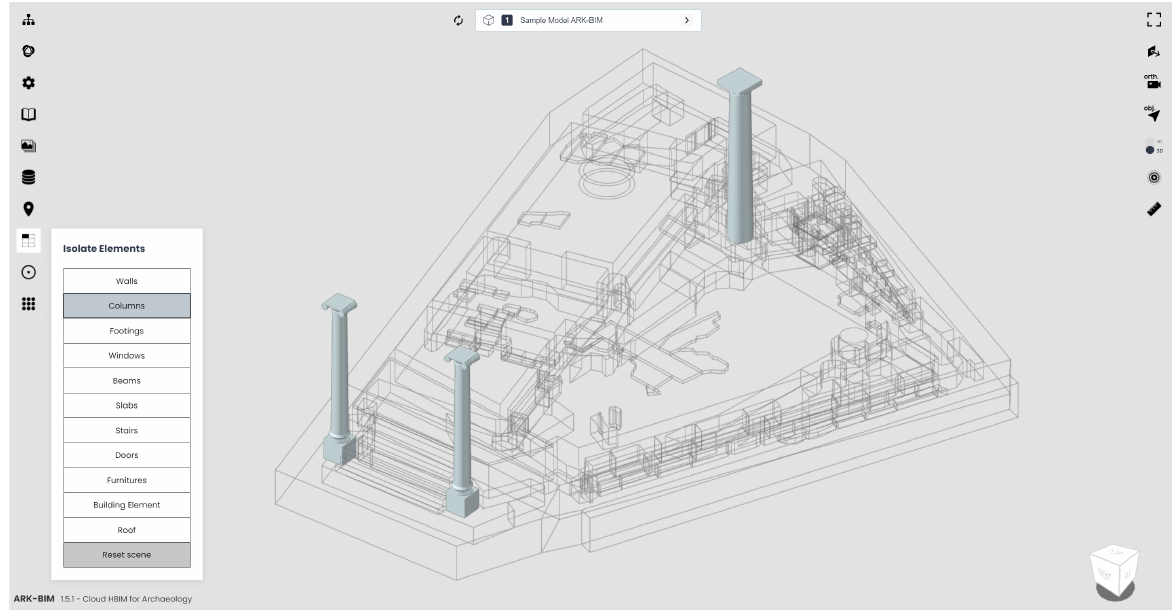
Figure 10. Part of source code related to the Isolate Elements plugin (the complete code is on the ARK-BIM website).